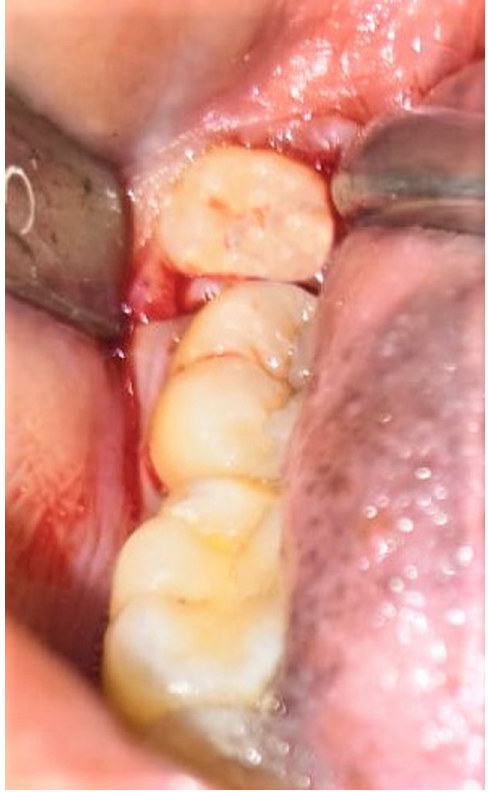
Fig. 4. Surgical exposure of lingual based triangular fl ap technique.